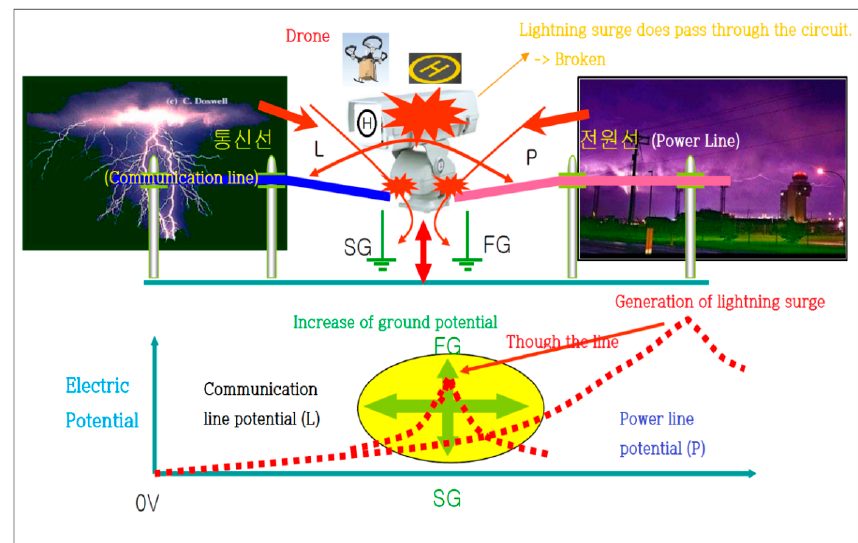
Figure 5. Penetration pathway.